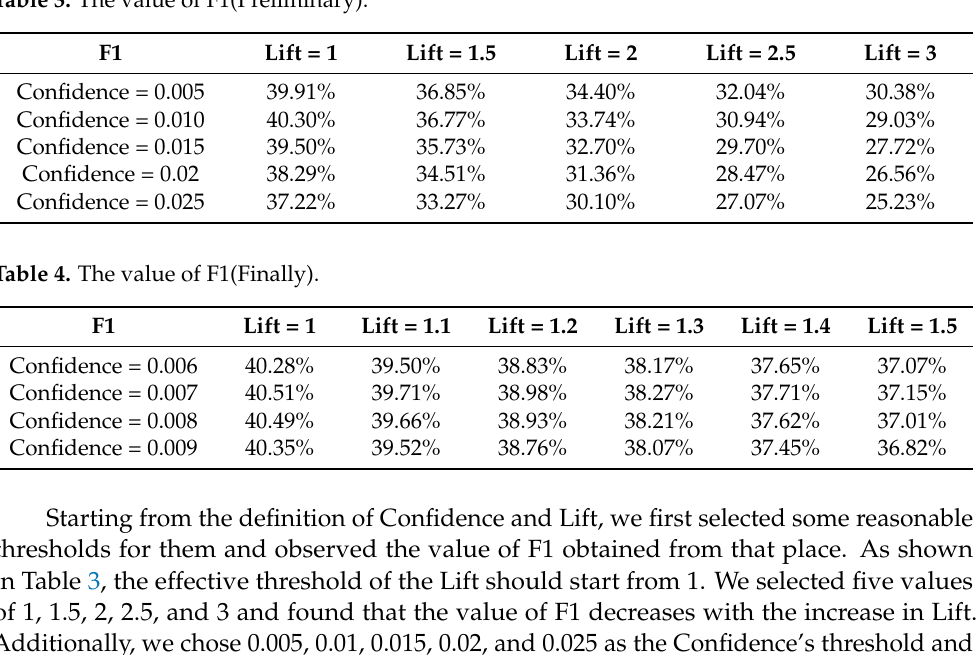
Table 3. The value of F1(Preliminary).